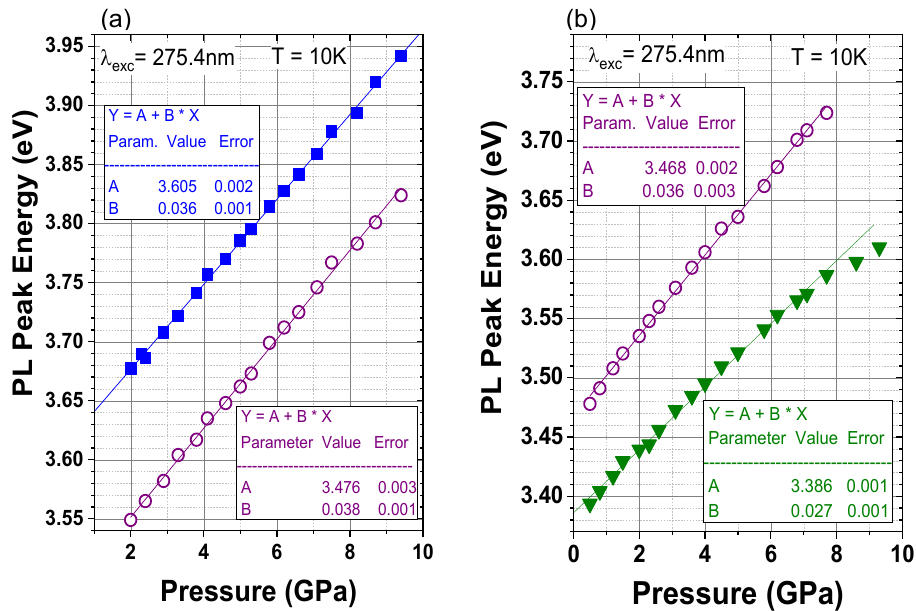
Figure 11. PL peak energies as a function of pressure for non-polar ( a ) and polar ( b ) GaN/AlGaN MQWs (filled symbols) and the GaN cap (open symbols). The pressure coefficients ( dE PL /dp ) are determined as a slope of the linear fits to the experimental data.